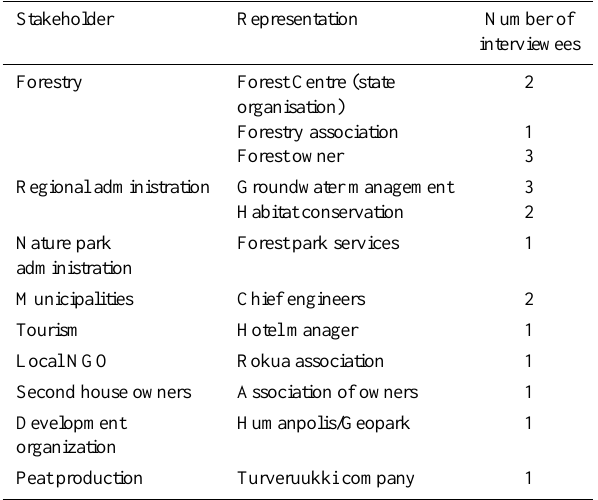
Table 1. List of stakeholder groups and representatives in the deci- sion analysis